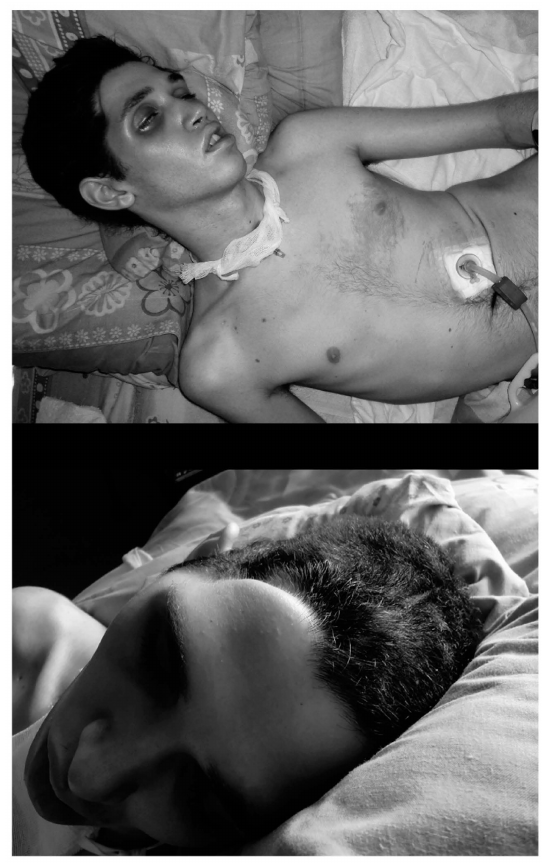
Figure 7. Deep coma occurred as a consequence of the axonal diffuse injury. ( Upper ) Few days after the accident occurred, the strong spasticity, more prominent in the left hemibody, led to the apparition of dorsal-lumbar scoliosis. Notice the gastric tube for feeding and the tracheostomy; ( Lower ) Remarkable parietal bones